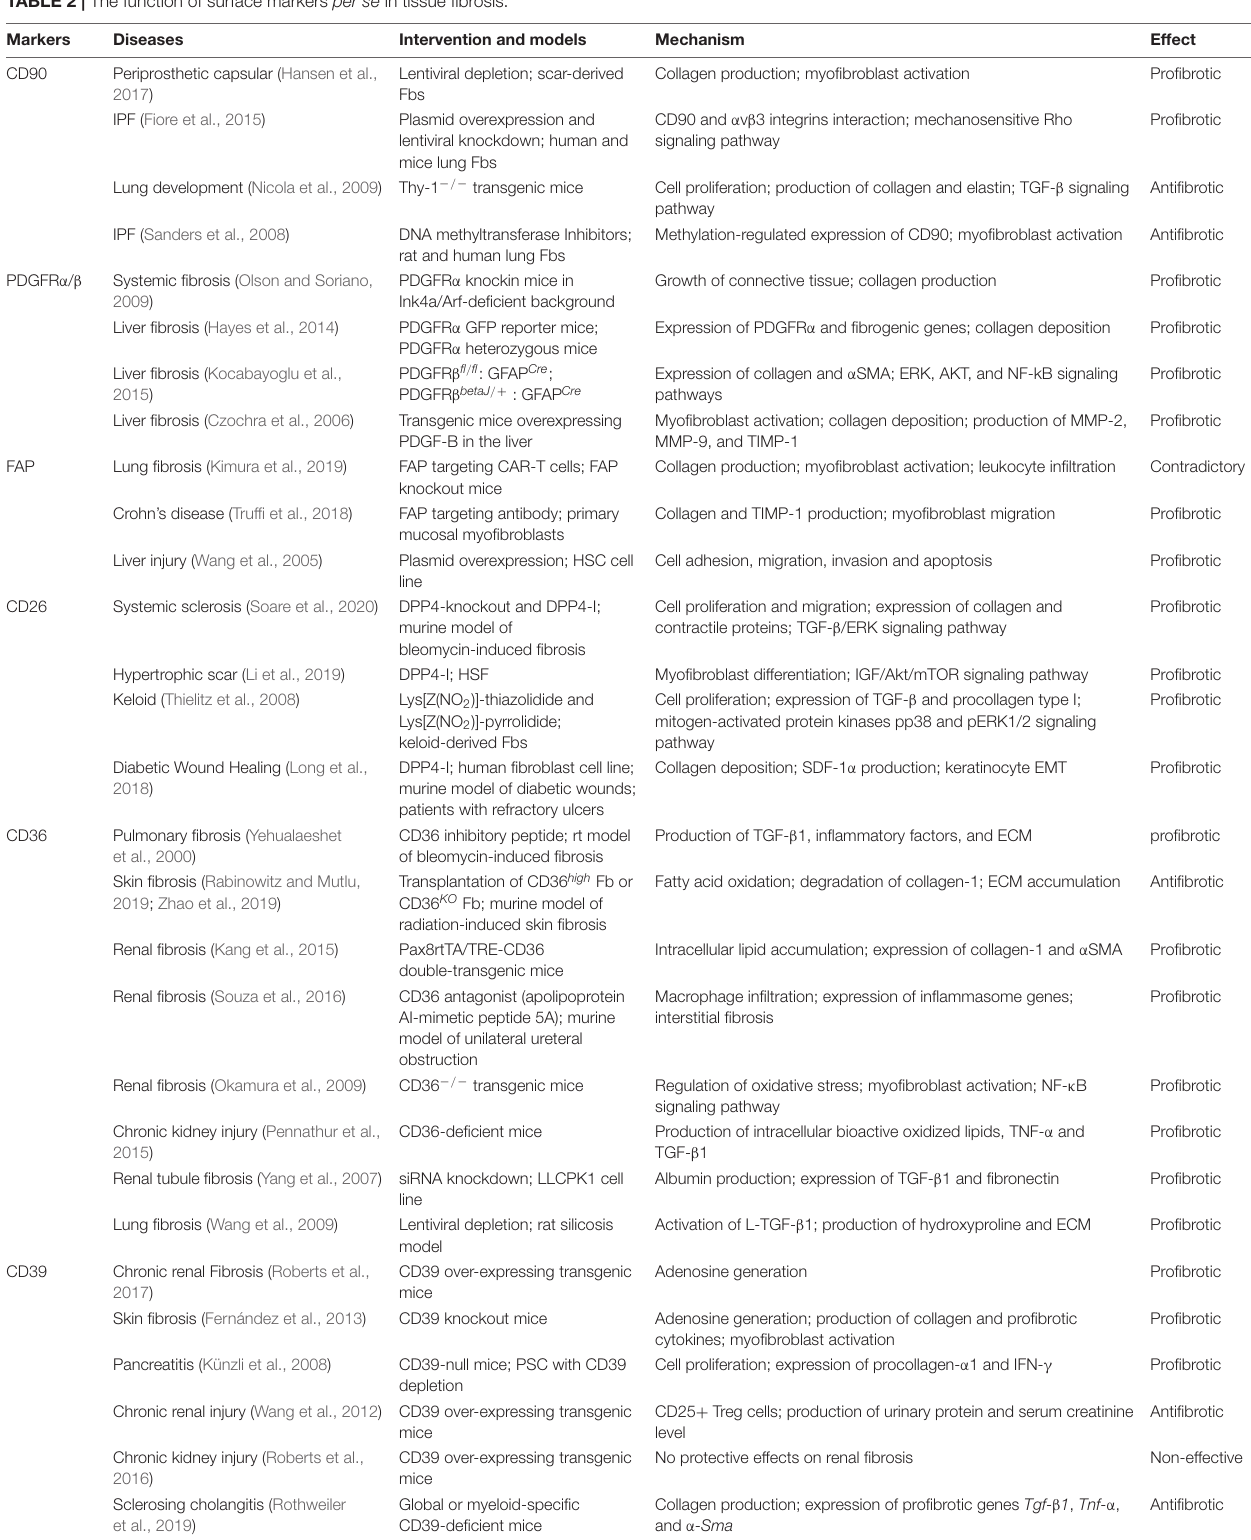
TABLE 2 | The function of surface markers per se in tissue